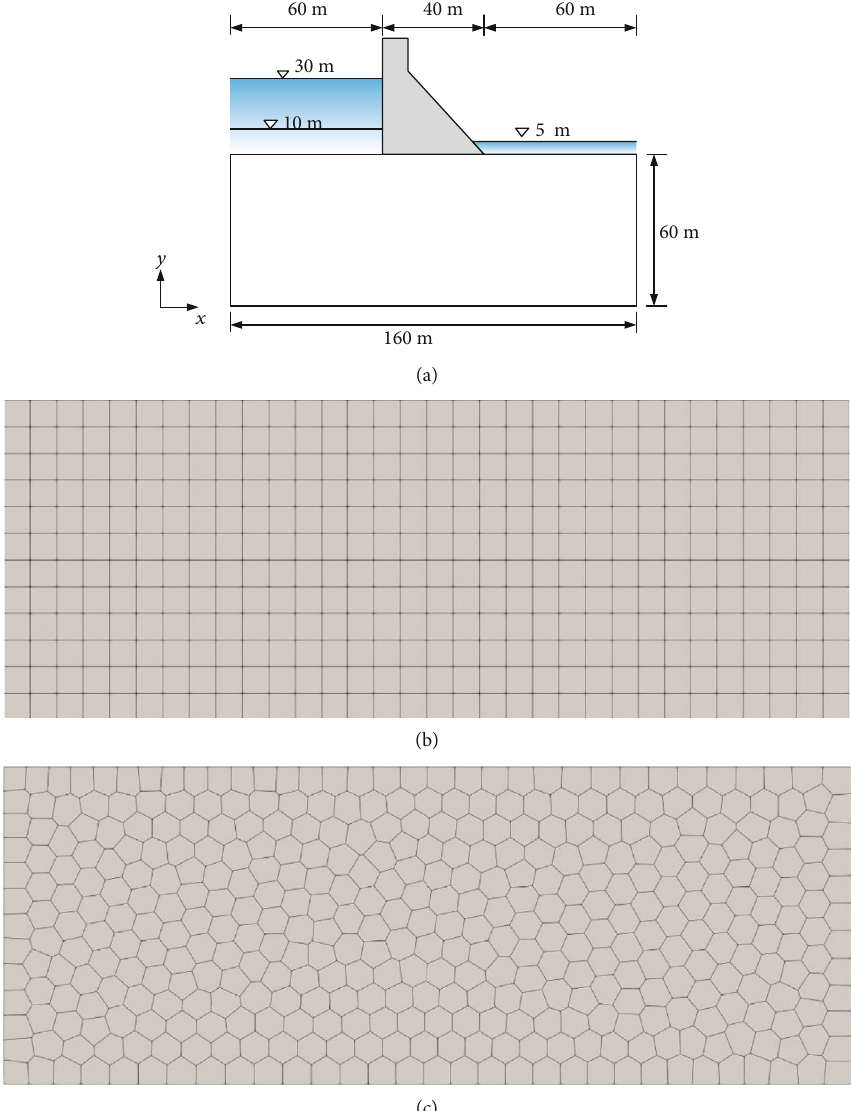
Figure 14: Transient seepage under a concrete dam constructed on anisotropic soil: (a) geometry and boundary conditions; (b) FEM mesh; (c) PSBFEM